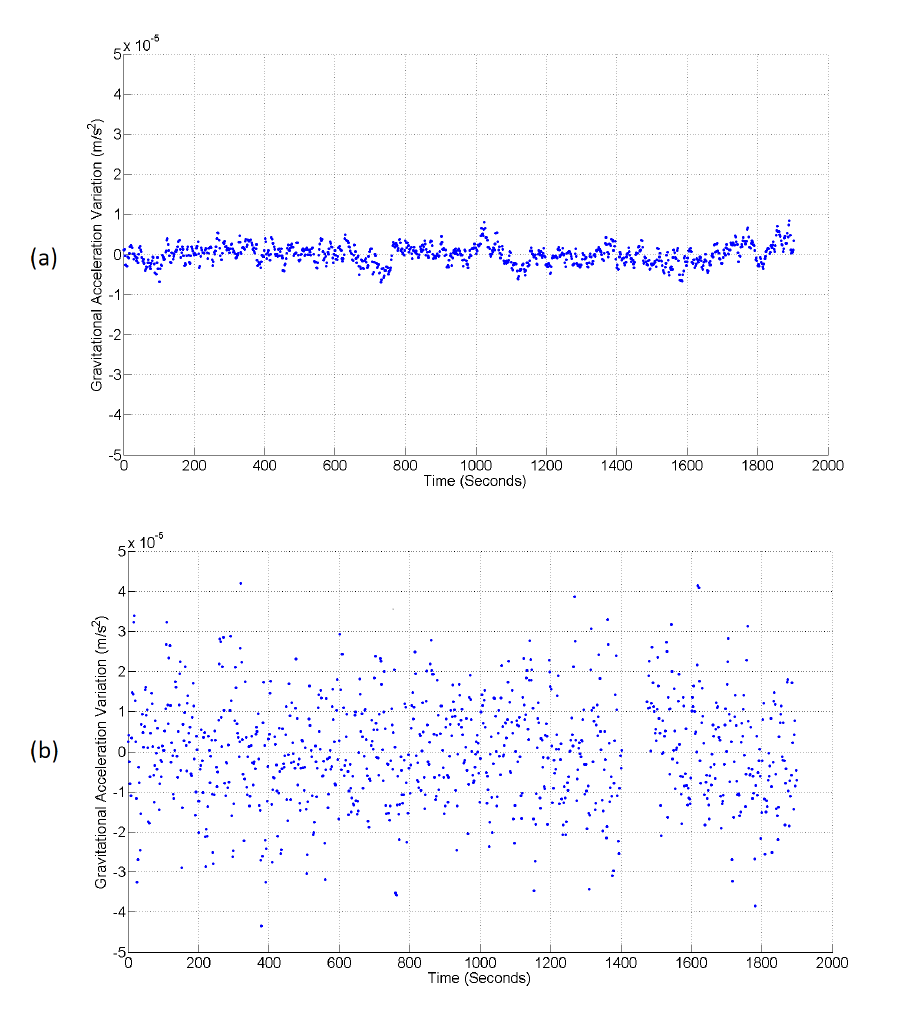
Figure 5. Two time series demonstrating the noise level of the gravimeter inside and outside (( a ) and ( b ) respectively). It can be seen that the noise level increases significantly outside the confines of the laboratory (with a standard deviation of 1.31 × 10 − 5 ms − 2 compared to 2.40 × 10 − 6 ms − 2 inside; each of these was calculated with an integration time of 2.13 s). The increased noise is due to the harsher environmental conditions: wind buffeting and larger temperature gradients. A short section of data has been removed from this series at 1400 s, where a loose connection was fixed; spiking the